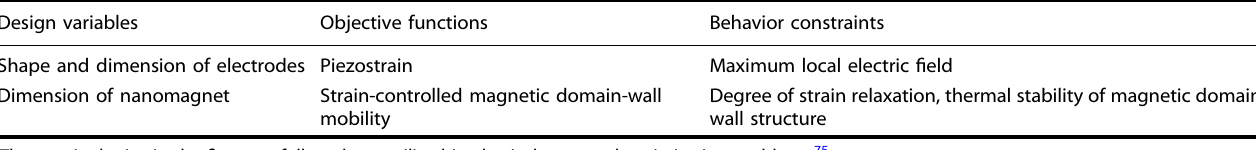
Table 2. Design parameters for the magnetoelectric device prototype based on the voltage-driven magnetic domain-wall motion (see Fig.